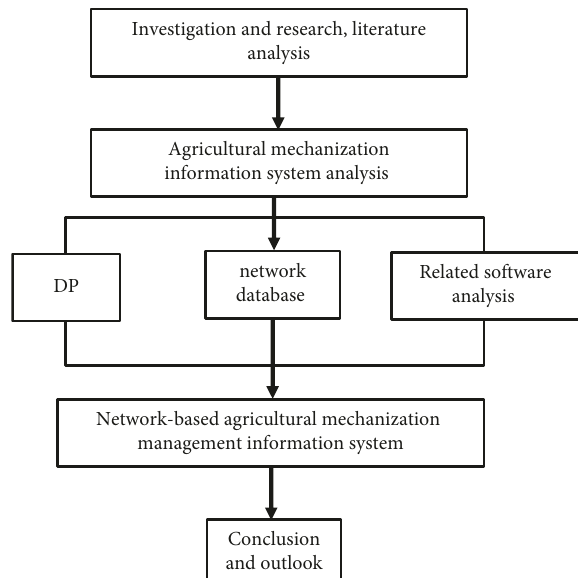
Figure 2: Idea diagram of network-based agricultural mechanization management information system. Table 1: Comparison of parameters of several common microcontroller core chips. Chip